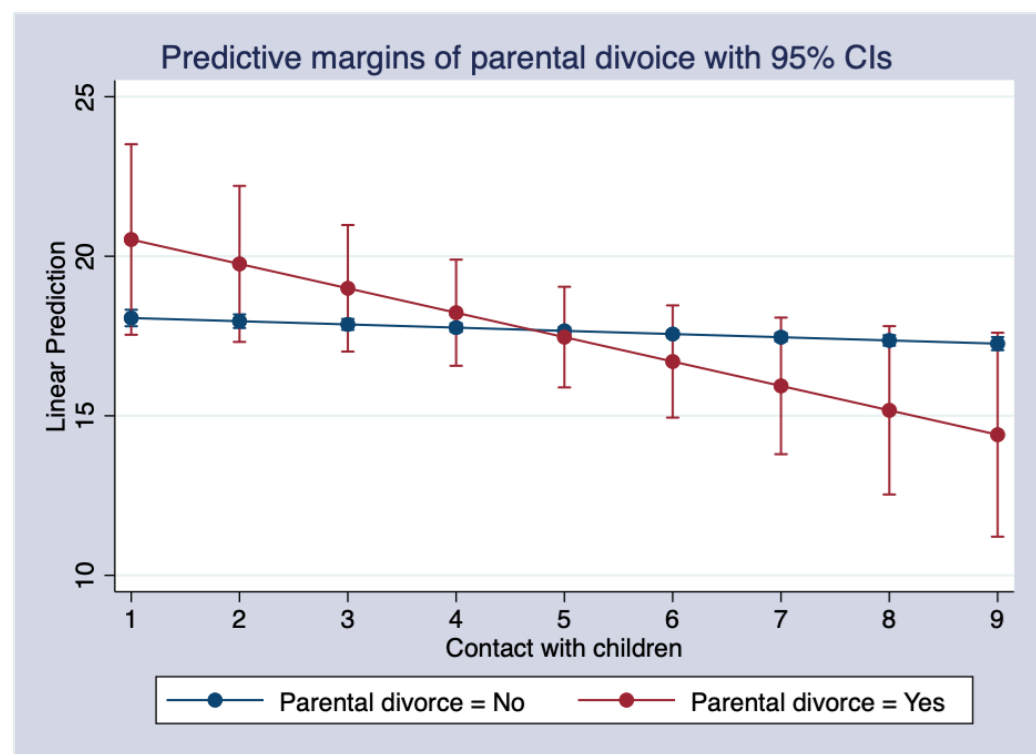
Figure A1. The marginal effects of contact with children on depression and parental divorce.